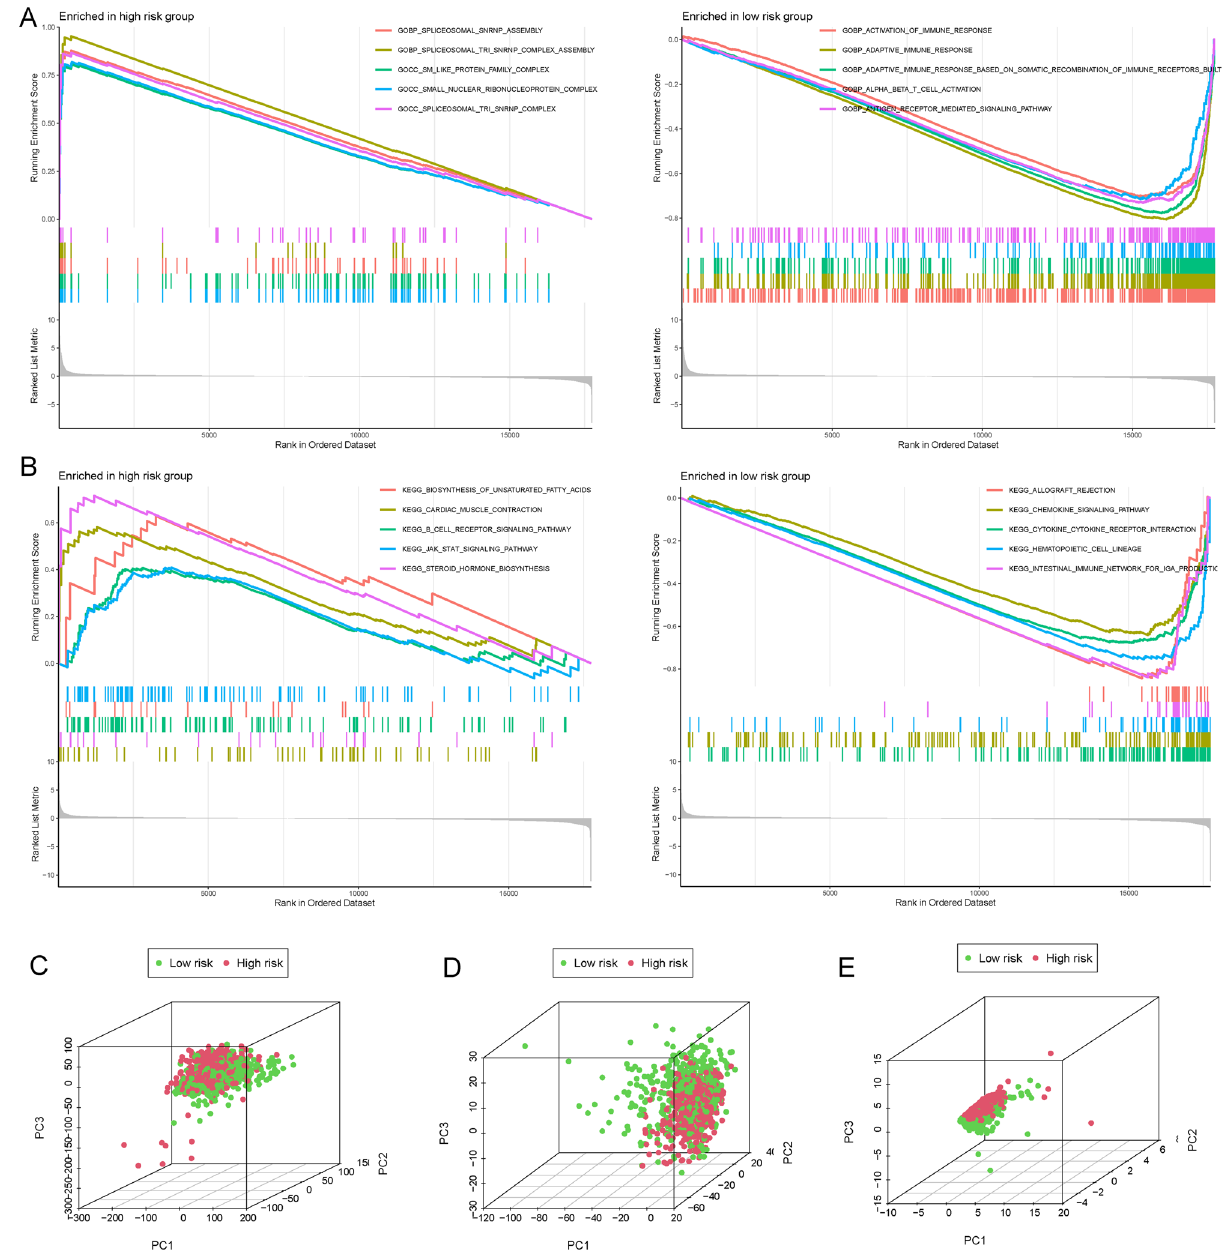
Figure 6. Analysis of differentially expressed genes between risk groups revealed enriched biological processes. Gene Ontology (GO) ( A ) and Kyoto Encyclopedia of Genes and Genomes (KEGG) ( B ) analyses of differentially expressed genes between the high- and low-risk groups based on the risk model in breast cancer (BC). The 3D scatterplot of principal component analysis (PCA) showed the distribution of BC patients based on the whole gene expression profile ( C ), all immune-related genes (IRGs) ( D ), and 7 IRGs ( E ). GO Gene Ontology, KEGG Kyoto Encyclopedia of Genes and Genomes, BC breast cancer, PCA principal component analysis, IRG immune-related